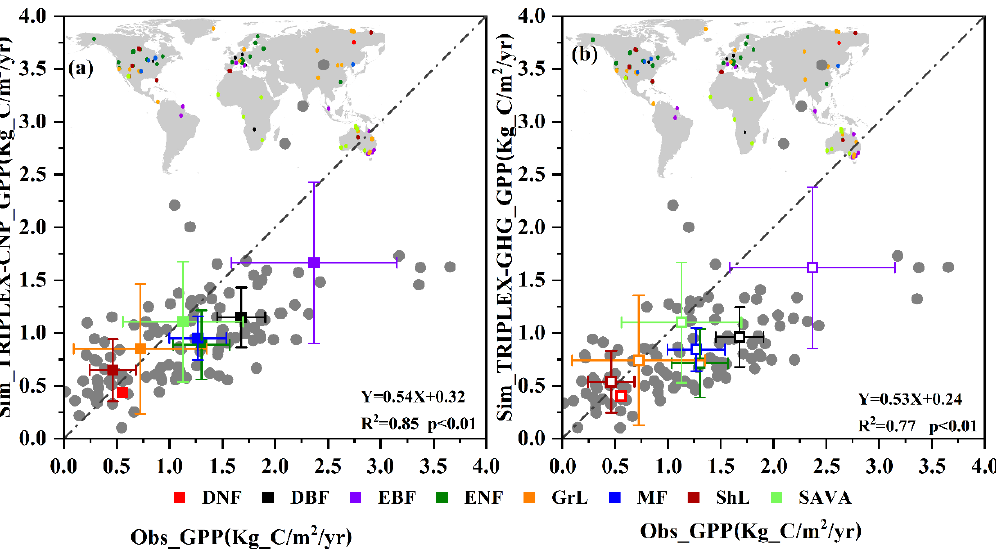
Figure 3. Comparisons of GPP simulated by TRPLEX-CNP ( a ) or TRPLEX-GHG without phosphorus cycle ( b ) and observed data. The gray points are data from 116 sites in FLUXNET. Colored squares show average GPP for different plant types, whose geographical distribution is shown at the upper left. The dashed line indicates a 1:1 relationship between simulated and observed GPP values. DBF, deciduous broadleaf forest; DNF, deciduous needleaf forest; EBF, evergreen broadleaf